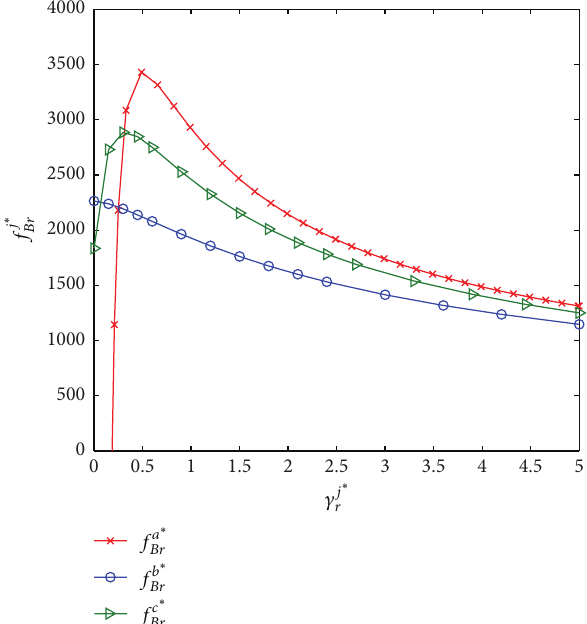
Figure 1: Without revenue sharing